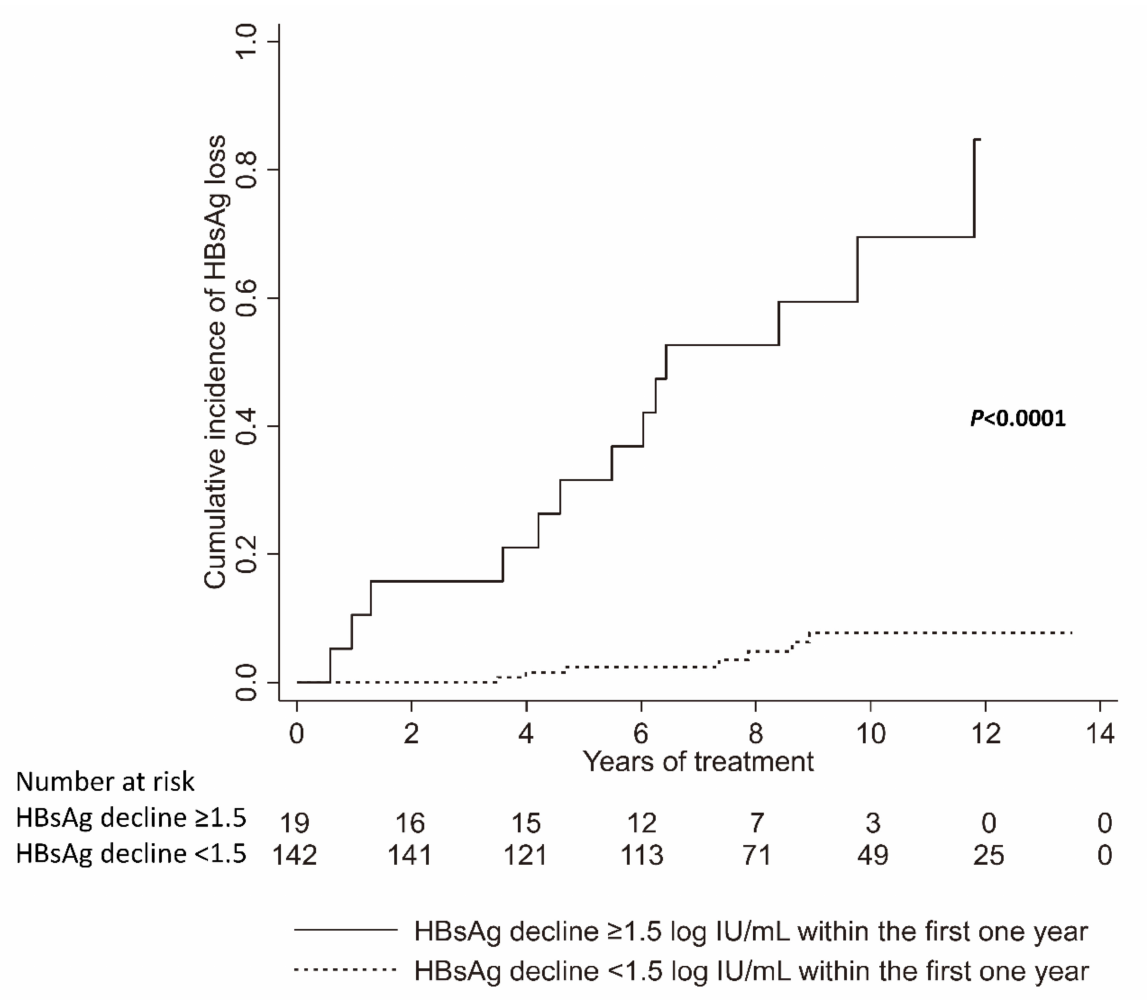
Figure 7. Cumulative incidence of HBsAg loss in chronic hepatitis B patients receiving nucleos(t)ide analogue treatment. Table 4. Univariate and multivariate analysis of factors associated with HBsAg loss after nucleos(t)ide analogue treatment. Univariate Factors